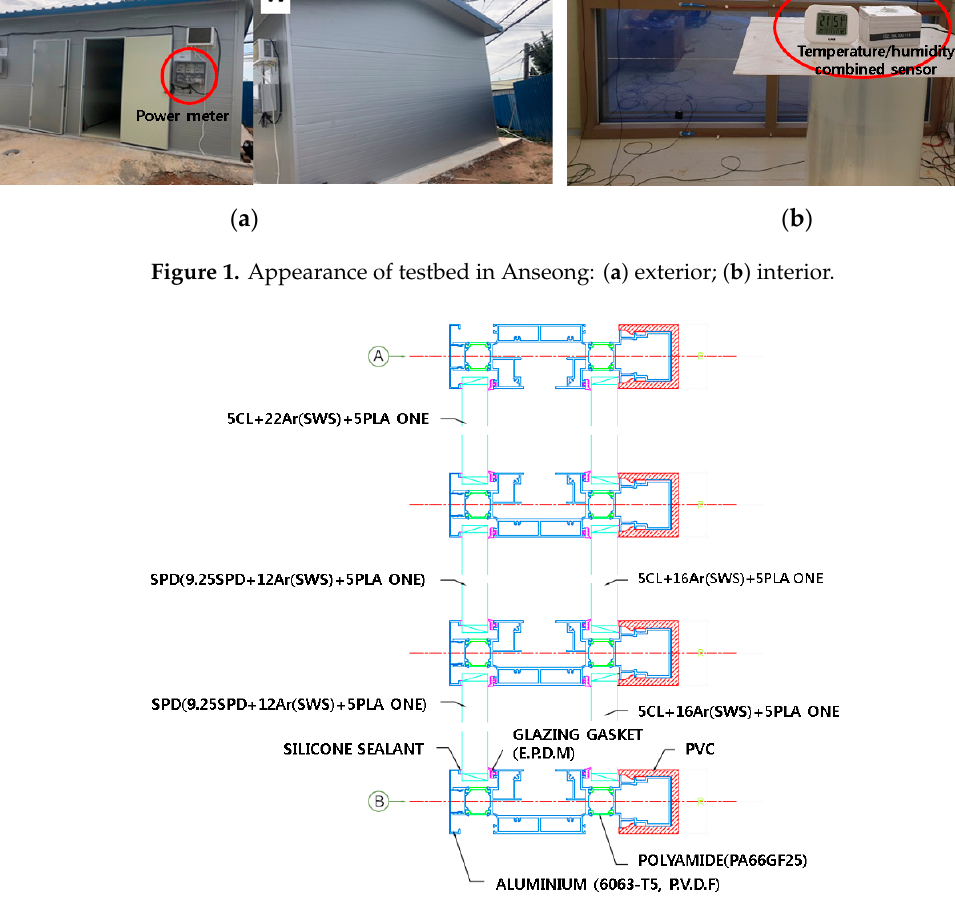
Figure 2. Sketch of the suspended particle device (SPD) window that consist of CL (Clear glass), Ar (SWS, Swiss spacer) and PLA ONE (Planitherm one).